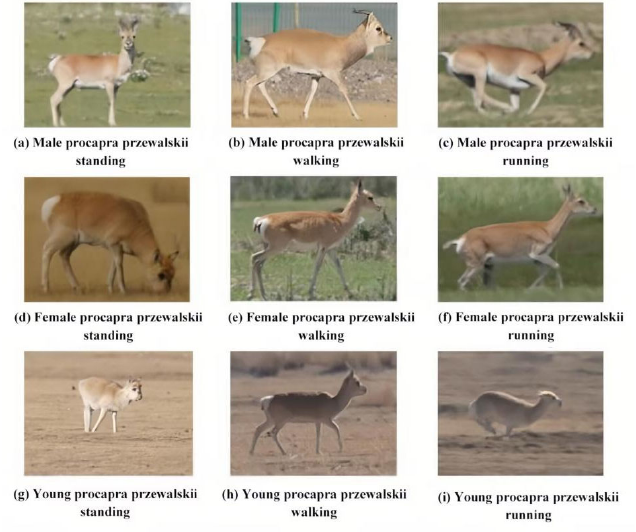
Figure 5. Di ff erent motions of male, female, and young Procapra przewalskii. Figure 5. Different motions of male, female, and young Procapra